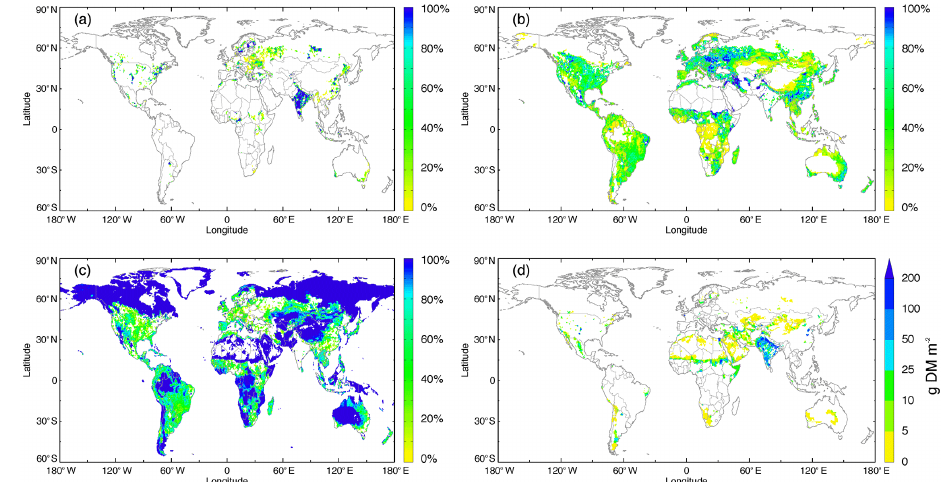
Figure 2. (a) Mown, (b) grazed, and (c) unmanaged fraction of global grassland, and (d) modelled grass-biomass production deficit of 2000. Modelled grass-biomass production deficit indicates the simulated grassland productivity in the grid cells is not sufficient to fulfil the grass-biomass use given by Herrero et al. (2013) and is expressed with units of g dry matter (DM) per m 2 of total land area in each grid cell. Table 2. Grass-biomass production deficits in regions where simulated productivity by ORCHIDEE-GM v3.1 (i.e. Y mown and Y grazed ; see text) cannot fulfil the grass-biomass use given by Herrero et al. (2013) for 2000. Regions a Grass-biomass use Production